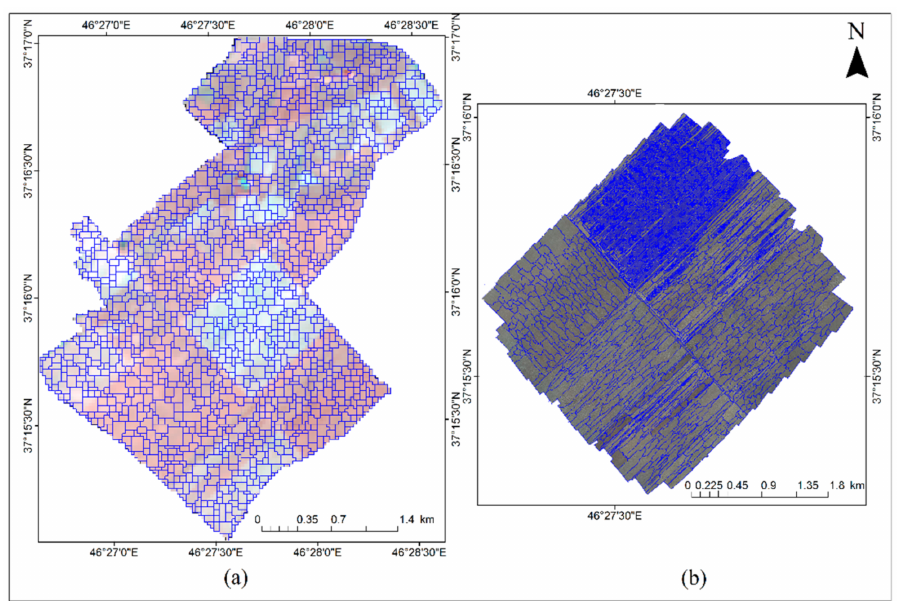
Figure 5. Multiresolution image segmentation process: ( a ) the multispectral Sentinel-2 satellite based image, and ( b ) the RGB image from the